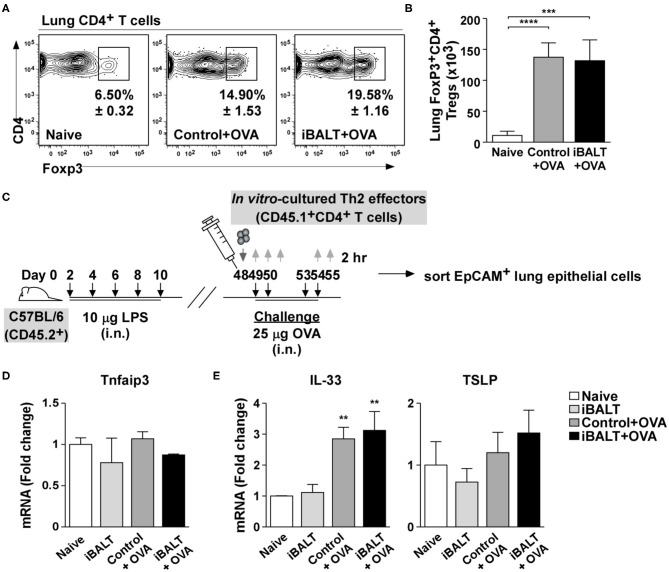
The presence of iBALT does not influence Treg accumulation or epithelial cell conditioning. Mice with and without iBALT were sensitized and challenged with OVA according to the schedule in Figure 1E and the frequencies (A) and numbers (B) of Foxp3+CD4+ T cells were determined by flow cytometry (mean ± SD of 4–5 mice per group; ***P < 0.001, ****P < 0.0001). (C) Timing of iBALT induction, Th2 transfer, antigen challenge and tissue collection. (D,E) mRNA expression of (D) Tnfaip3 and (E) IL-33 and TSLP from sorted lung epithelial cells was determined by quantitative PCR 2 h after the last OVA challenge. Data is normalized to the expression in naïve lung (mean ± SD of 4–5 mice pooled per group; **P < 0.01). Experiments were performed 4 times (A,B) or 3 times (C–E).